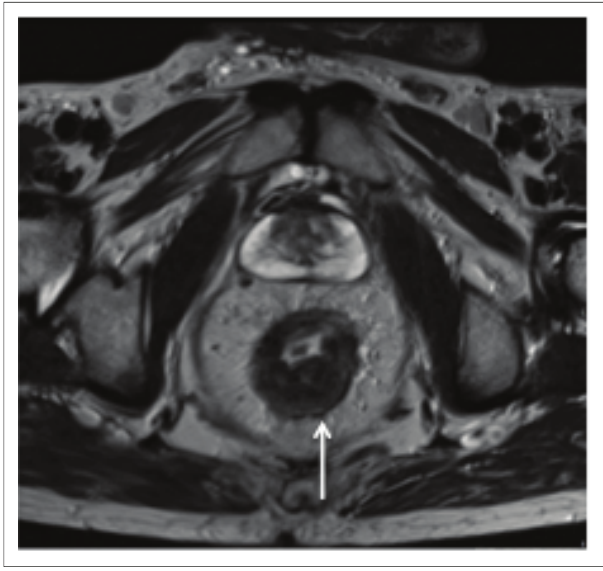
MRI, Magnetic resonance imaging. FIGURE 10: Axial T2-weighted MRI imaging. The patient is a 50-year-old male with thickening of the posterior wall of the rectum. MRI was performed to aid surgical